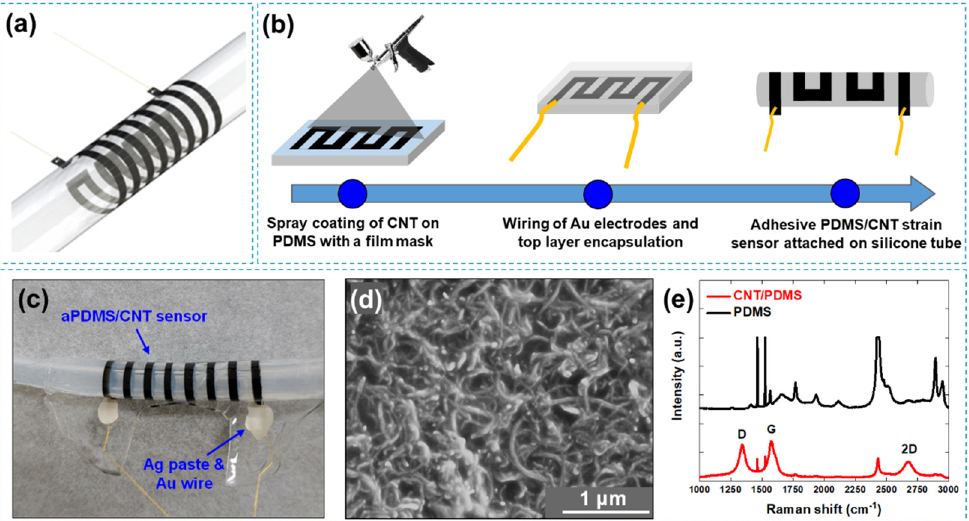
Figure 1. ( a ) A schematic of adhesive PDMS (a − PDMS)/CNT strain sensor; ( b ) fabrication process of the sensor implementing the CNT spray deposition; ( c ) image of the a-PDMS/CNT sensor; ( d )